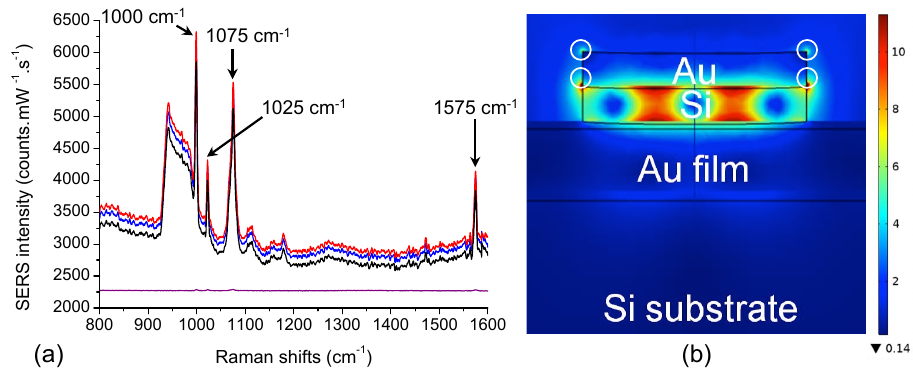
Figure 4. ( a ) SERS spectra of thiophenol realized on 3 distinct SERS substrates among 10 for the excitation wavelength of 785 nm. In purple is represented the SERS spectrum of thiophenol (1 mM) obtained on a 40-nm gold film at the same excitation wavelength (an offset is applied to the purple spectrum to see all the SERS spectra). ( b ) Electric field mapping | E / E 0 | of a hybrid Au/Si nanodisk on gold film for an excitation wavelength of 785 nm (cross-sectional view). White circles correspond to the strong electric field zones accessible for thiophenol